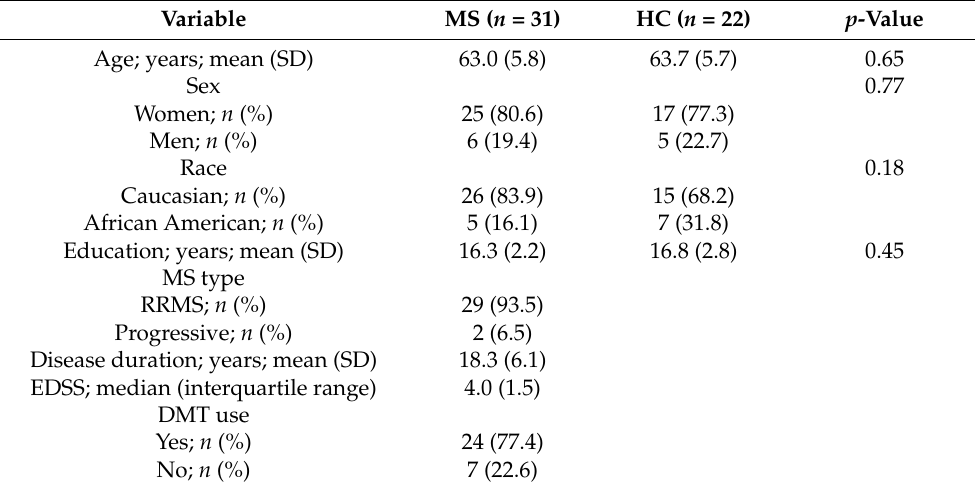
Table 1. Demographic and clinical